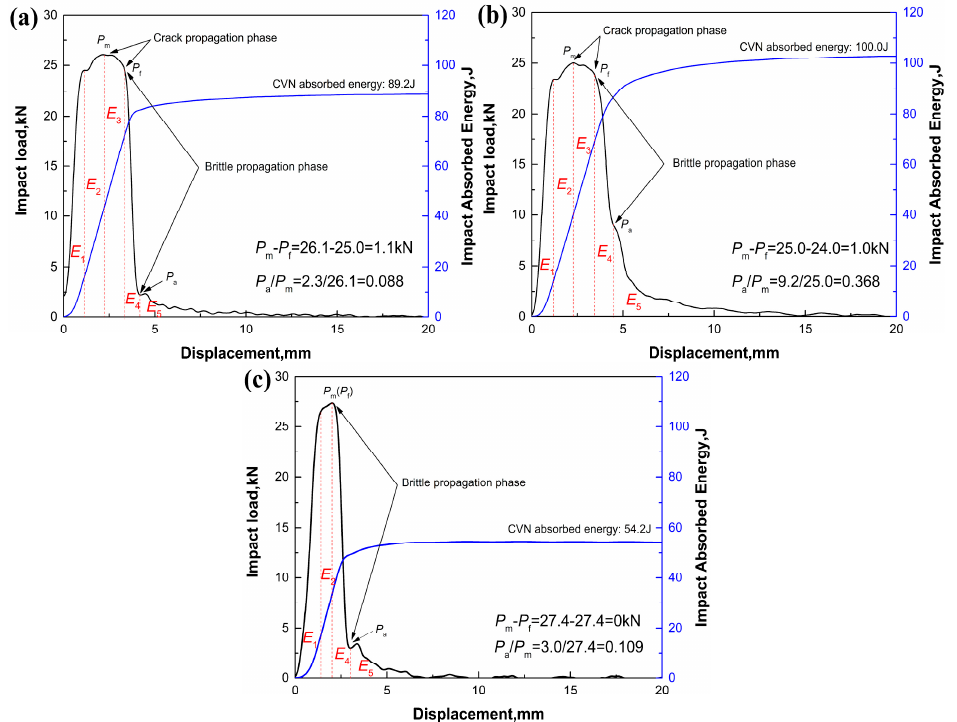
Figure 8. Micrographs of the impact fracture tested at − 60 °C. ( a ) sub-surface, ( b ) t /4, c t /2, ( d , g )